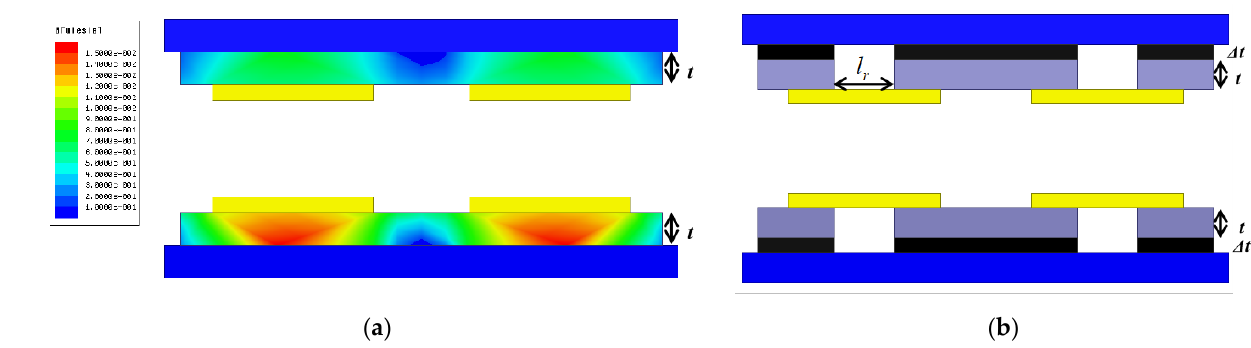
Figure 9. Target area of optimizing progress: ( a ) Distribution of flux density; ( b ) Optimized 2D model.